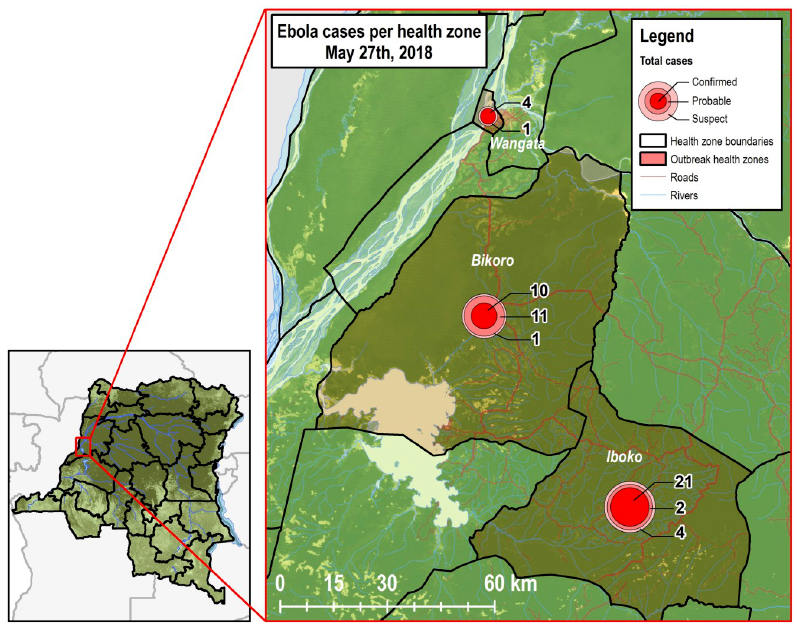
Fig 1. Map of cases of Ebola virus disease per health zone in E´quateur Province, Democratic Republic of Congo, as of May 27, 2018 (Source: Hansen/UMD/Google/USGS/NASA[24]).